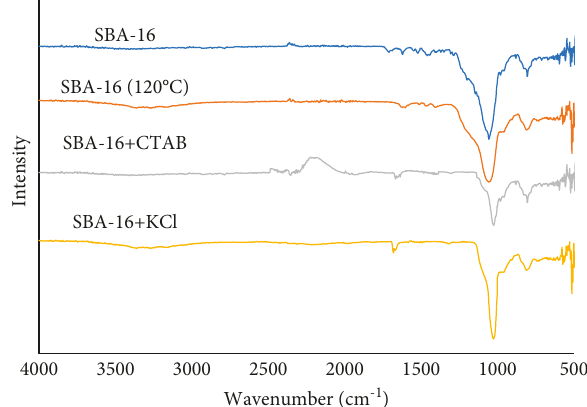
Figure 1: FT-IR spectra of all prepared samples.